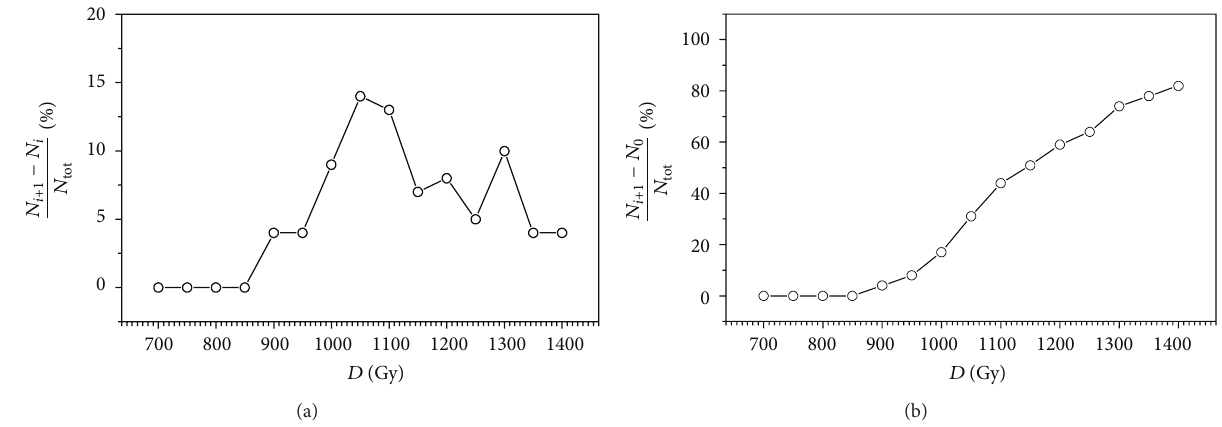
Figure 2: Theaverage relative change in numberof errorsinirradiated EEPROMsamples (NM93CS46)versustheabsorbed doseof radiation: (a) differential; (b) cumulative ( 𝑁